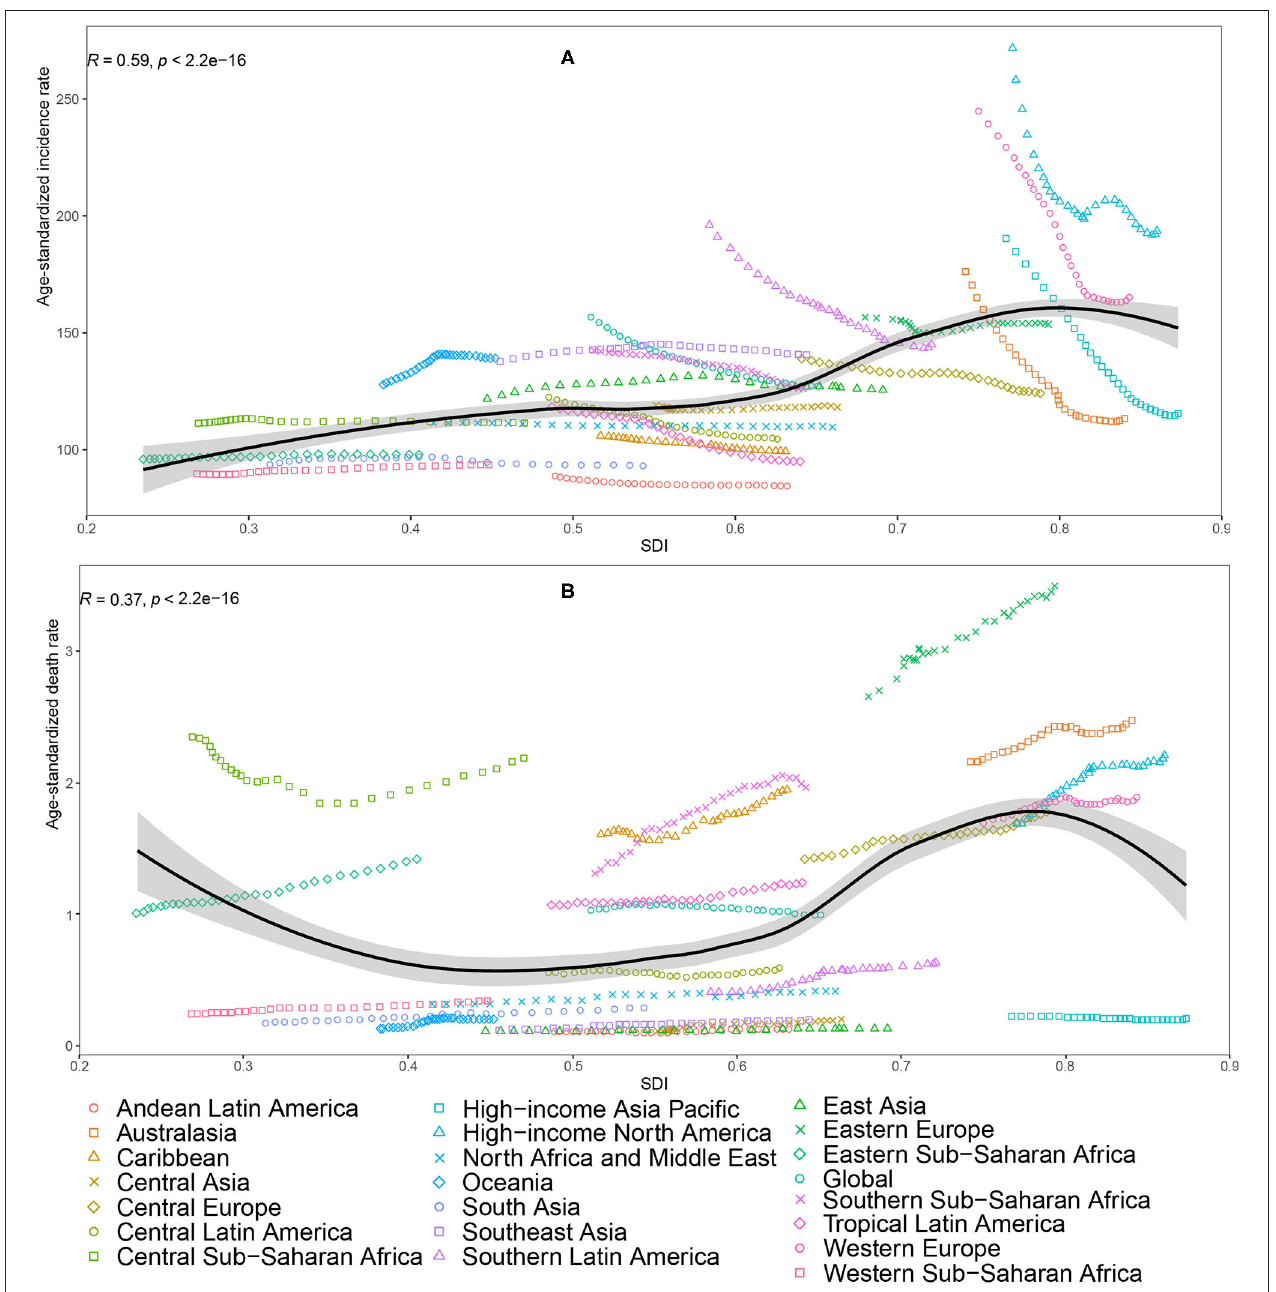
FIGURE 3 | Age-standardized incidence rate (A) and age-standardized death rate (B) of peripheral artery disease for 21 Global Burden of Disease (GBD) regions by Socio-Demographic Index (SDI), 1990–2019; expected values based on SDI and disease rates in all locations are shown as the black line. Thirty points are plotted for each GBD region and show observed rate from 1990 to 2019 for that region. The R indices and P -value were derived from Pearson correlation analysis.